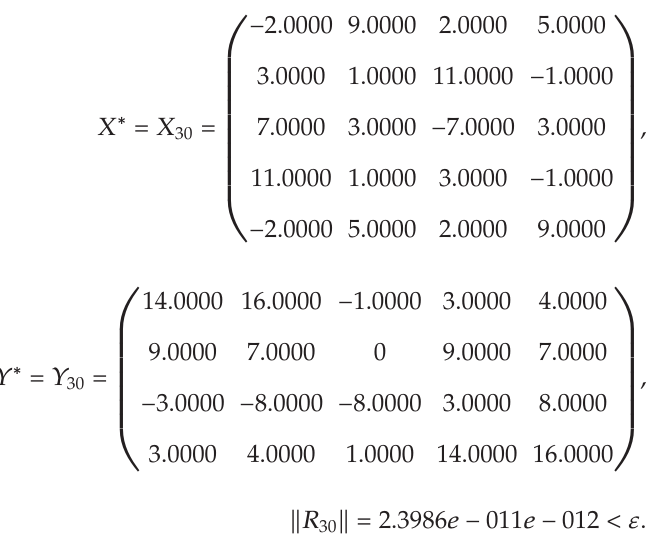
By using Algorithm 2.1, we have the least-norm generalized reflexive solutions of the matrix equations AXB − CYD (cid:4) M, EXY − GYH (cid:4) N as